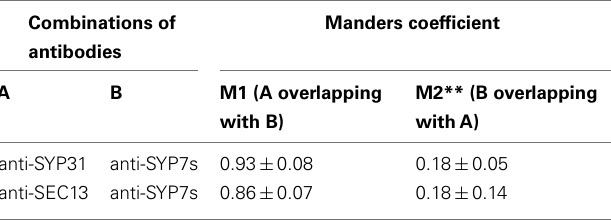
Table 2 | Colocalization of endogenous Golgi (anti-SYP31), COPII (anti-SEC13), and ERIS (anti-SYP7s) in tobacco BY-2 suspension culture